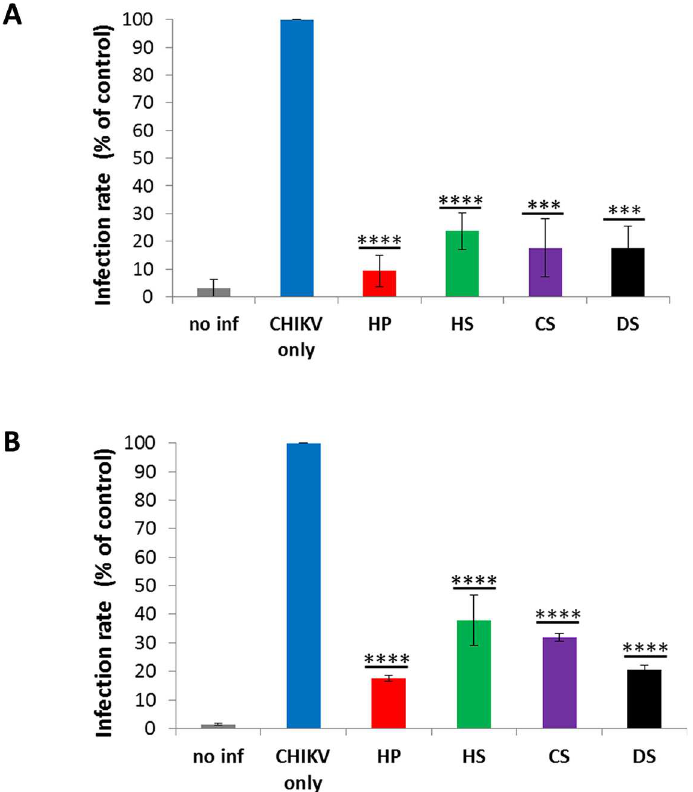
Fig 3. Infection and cell entry by CHIKV-mCherry-490in the presenceof soluble GAGs. A: 293T cells were seeded in 24-wellplates and 500 μ g/ml of the indicatedGAG was added.Afterwards, cells were infected with CHIKV-mCherry-490using an MOI of 1. The viral replicationwas determined6 hrs post-infection by flow cytometry detectingmCherry. B: 500 μ g/ml of the indicatedGAG and CHIKV-mCherry-490(MOI 1) were incubatedtogether at 4˚C for 30 minutes. After additionto 293T cells, anotherincubationof 30 minutes at 4˚C followed.Then, the unboundvirus together with the respectiveGAG were washedaway and fresh medium was added to the cells. The viral replicationwas determined 6 hrs post-infection by flow cytometry detecting mCherry. Data represent the averageof three independent experiments. *** and **** indicate significant differences in infectionrates to untreated control cells. ** (P (cid:20) 0.01) and *** (P (cid:20)